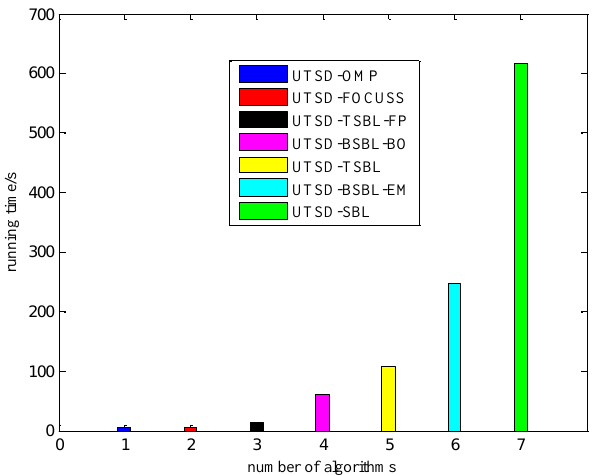
Figure 8. Running time comparison of different algorithms with UTSD.